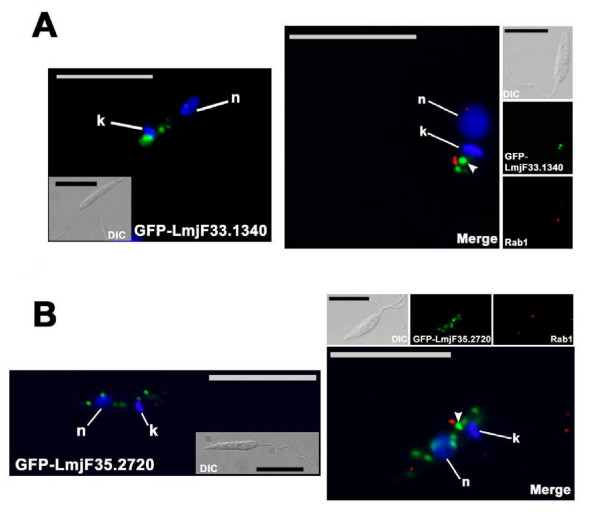
GFP-LmjF35.2720 and GFP-LmjF33.1340 label punctate structures. Localisation of GFP-fused LmjF33.1340 (A) and LmjF35.2720 (B) in live (left hand side) or fixed (right hand side) L. major promastigotes. Corresponding DIC images are shown; the GFP fluorescence signal is shown in green and immuno-labelling with Golgi marker Rab1 is shown in red. The merged fluorescent signals, together with the DAPI staining of DNA (blue; n: nucleus; k: kinetoplast) are shown in the enlarged image. Arrowheads point the predominantly fluorescent signal located close to the Golgi staining. Scale bar = 10 μm.